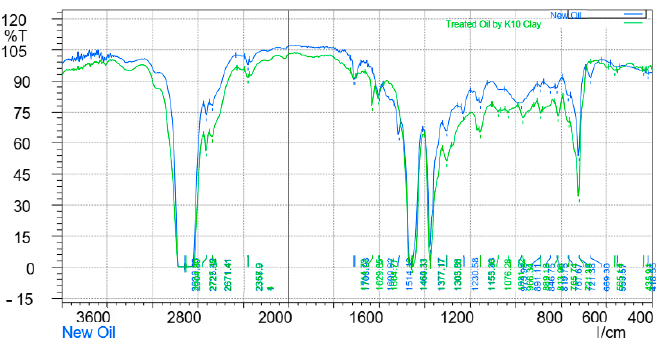
Figure 11. Superposition of IR spectra: oil treated with K10 clay and new oil.